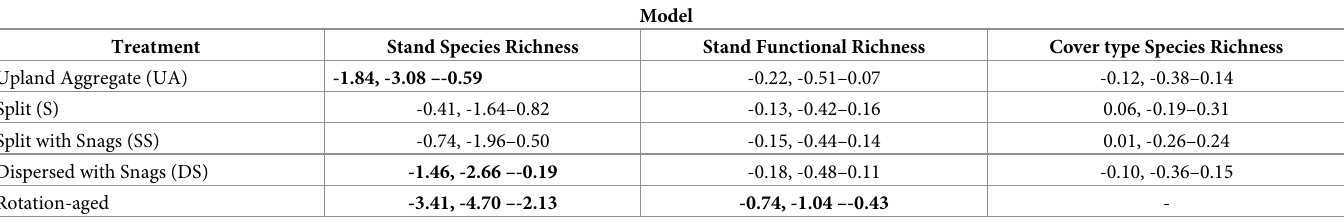
Table 1. Coefficient estimates and 95% confidence intervals from linear mixed-effects models (Gaussian response) predicting stand-scale small mammal species and functional richness by structural retention treatment, northwest Oregon and southwest Washington, USA,